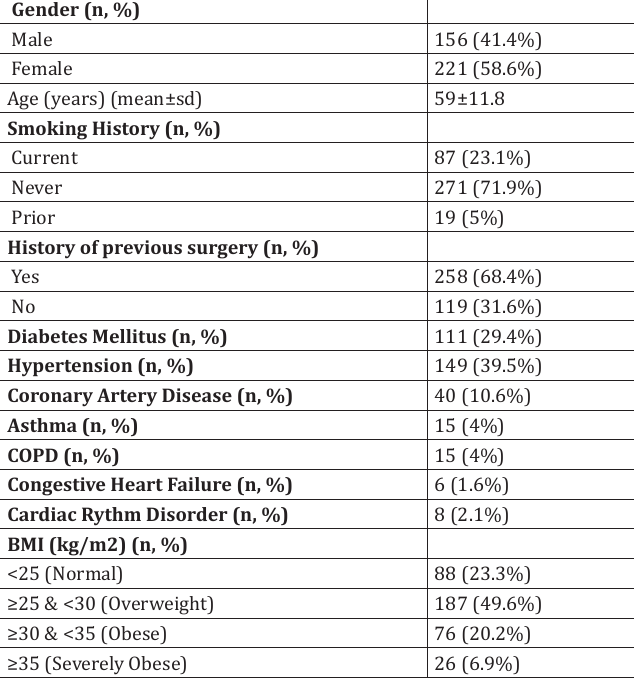
Demografic data and